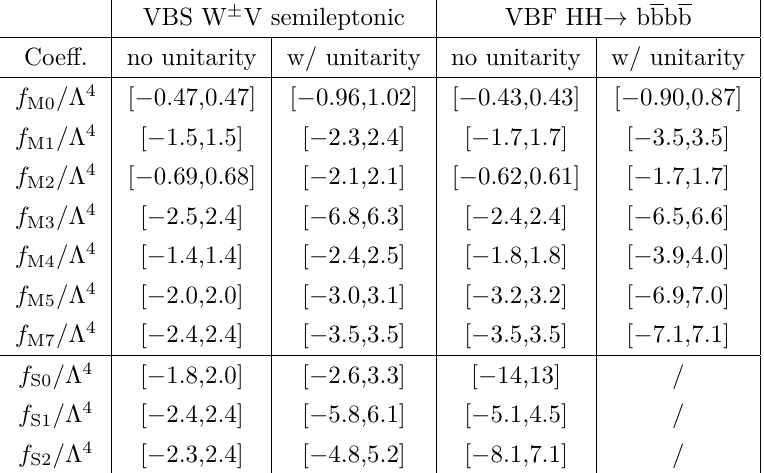
Table 6 . Comparison of VBF-HH constraints with those obtained from VBS when applying or not unitarity constraints, in a projection with full HL-LHC luminosity. All entries represent 95% CL lower and upper limits in units of TeV − 4 . Bars represent processes for which there is no sensitivity to the corresponding operator, or cases where the theoretical unitarity bound is more stringent than the experimental one for all m cut-off values. max